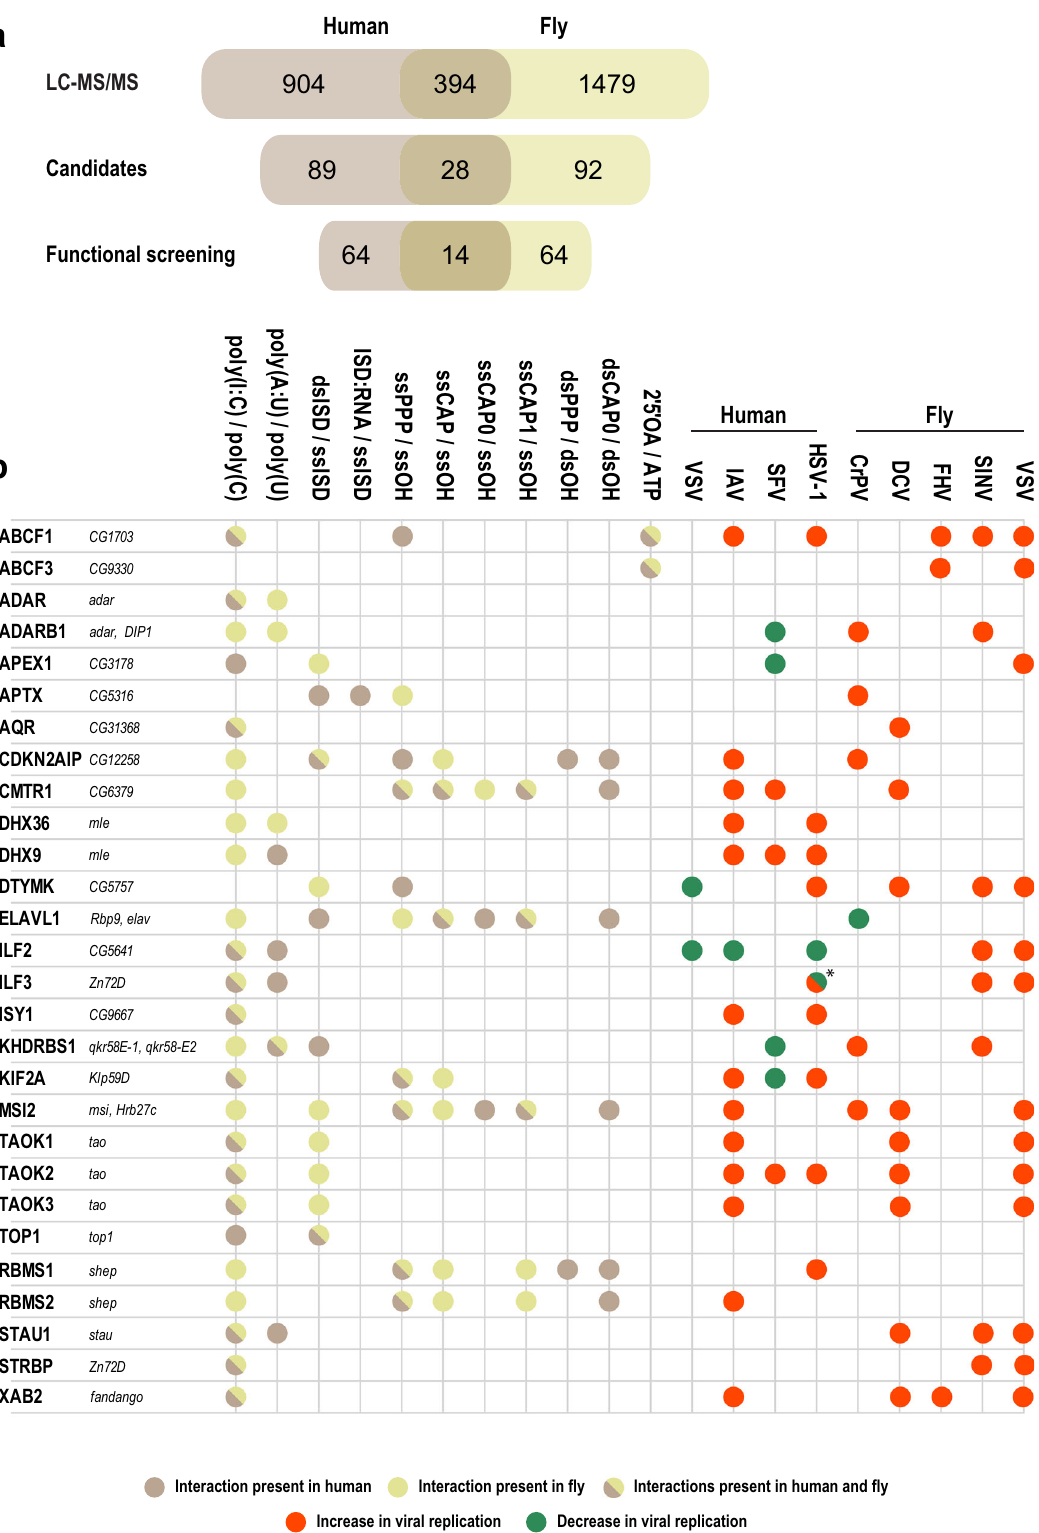
Fig. 9 Summary of screening results. a Overlap of proteins between human (brown) and fl y (green; combined results from drosophila and S2 cells), which were identi fi ed as NA binder in the AP-MS screen (LC – MS/MS), selected as candidates for further functional validation (Candidates) and that showed an anti- or proviral phenotype upon depletion (Functional screening). Orthologue mapping between human and fl y proteins was performed using DRSC Integrative Ortholog Prediction Tool. b Overview of the results gathered in the screening approaches in humans and fl y for the 28 top candidates (red: antiviral, green: proviral). Shown are human proteins with annotated orthologues in fl y. *for ILF3 we observed an increase of viral replication in PMA treated THP-1 cells, but a decrease of viral replication in the untreated THP-1